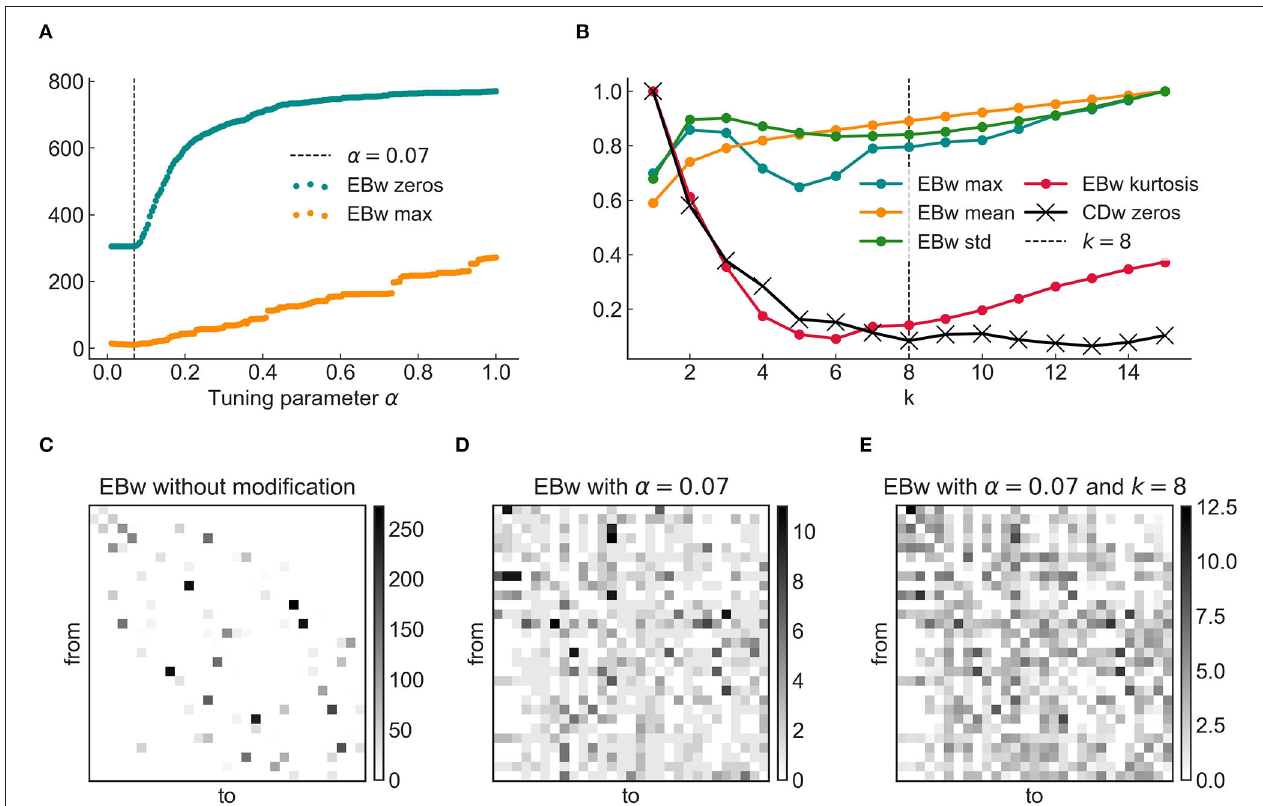
FIGURE 4 | Optimization of the parameters α and k . (A) The number of unused edges (those with a zero weighted edge betweenness, or EBw value) and the exclusive popularity of a few edges (the maximum of all EBw values) were minimized while keeping the significance of the weights ( α ) at the highest value possible. (B) Normalized EBw statistics and number of edges with a zero weighted convergence degree (CDw) as a function of k , i.e., the number of shortest paths considered for each pair of nodes. The maximum, mean and standard deviation of the EBw did not change considerably. The kurtosis fell to a minimum around k = 6 and started to increase again, while the number of zero CDw values reached a minimum around k = 8 and did not change significantly afterwards. Jointly minimizing the kurtosis of the EBw and the number of zeros in the CDw resulted in an optimal parameter value k = 8. (C–E) Three adjacency matrices showing the EBw values as weights. (C) Without the extra parameters, most edges were unused and the workload was unrealistically huge on a few super-popular edges. (D) The shortest path structure resulting from the optimal α had a much more reasonable distribution. The number of zeros was the lowest possible (white cells in the matrix are absent edges), although most edges supported only a single shortest path (i.e., the edge itself connecting the two nodes at its ends). (E) Applying the optimal k distributed the communication load more evenly by placing more weight on barely frequented